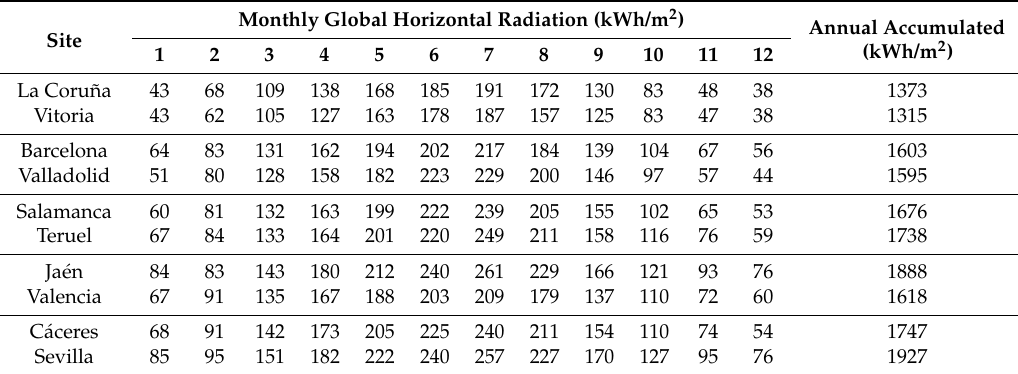
Table 15. Global Horizontal